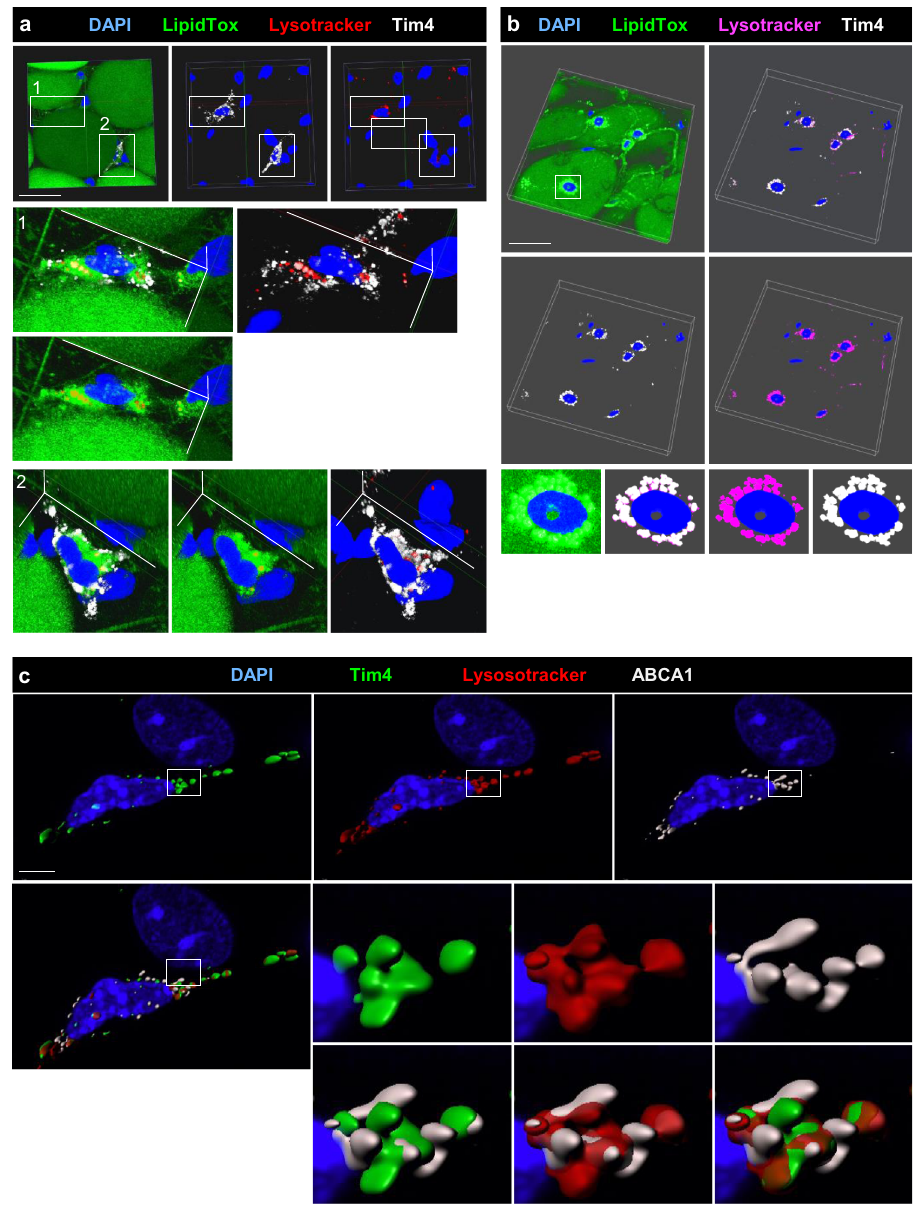
Fig. 4 Tim4 is closely associated with the lysosomes in murine and human ATMs. a Confocal imaging and 3D reconstruction of wholemount murine epididymal AT immuno fl uorescence staining with DAPI (blue), LipidTox green, lysotracker (red), and Tim4 (white). Clipped view showing Tim4 + ATMs found inside the AT are shown in enlargement 1 and 2. Staining representative of n = 8 mice in 2 independent experiments. b Confocal imaging and 3D reconstruction of wholemount immuno fl uorescence staining of human omental AT with DAPI (blue), LipidTox (green), lysotracker (magenta), and Tim4 (white). Enlargement of Tim4 + ATM is shown on the last line of the panel. Staining representative of n = 4 patients. Scale bar 50 μ m. c Confocal imaging and 3D reconstruction (IMARIS Software) of wholemount murine epididymal AT immuno fl uorescence staining with DAPI (blue), Tim4 (green), lysotracker (red), and ABCA1 (white). Enlargement are shown on the six images on the lower right-hand side of the panel. Staining representative of n = 4 mice in 2 independent experiments, Scale bar 4 μ HFD feeding led to a marked increase in the membrane expression of CD36 on all ATM subsets (Fig. 6g), in agreement with the scRNA-seq data, indicating that ATMs rapidly increase their capacity to uptake lipids upon high fat feeding (Fig. 5c).